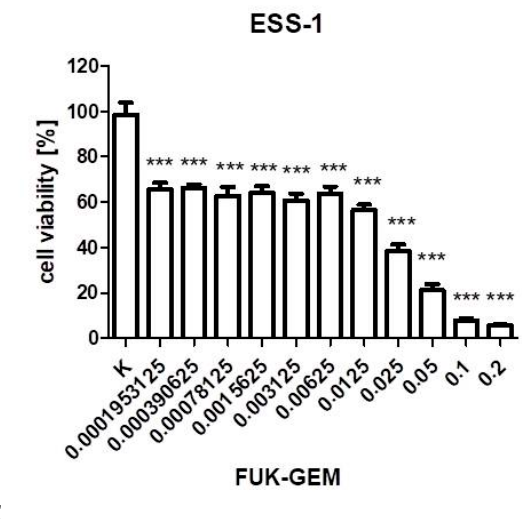
Figure 5. The influence of combined fucoidan and gemcitabine on the proliferation of carcinosarcoma cell lines (SK-UT-1 ( A ), SK-UT-1B ( B )) and endometrial stromal sarcoma cell line (ESS-1 ( C )). The cells were treated with fucoidan and gemcitabine at various concentrations for 96 hours. (** p < 0.01, *** p < 0.001 were considered as statistically significant). The values on axis X represent the multiplicity of calculated IC 50 . The combinations of gemcitabine and fucoidan were mixed 1:1 before added to cells.